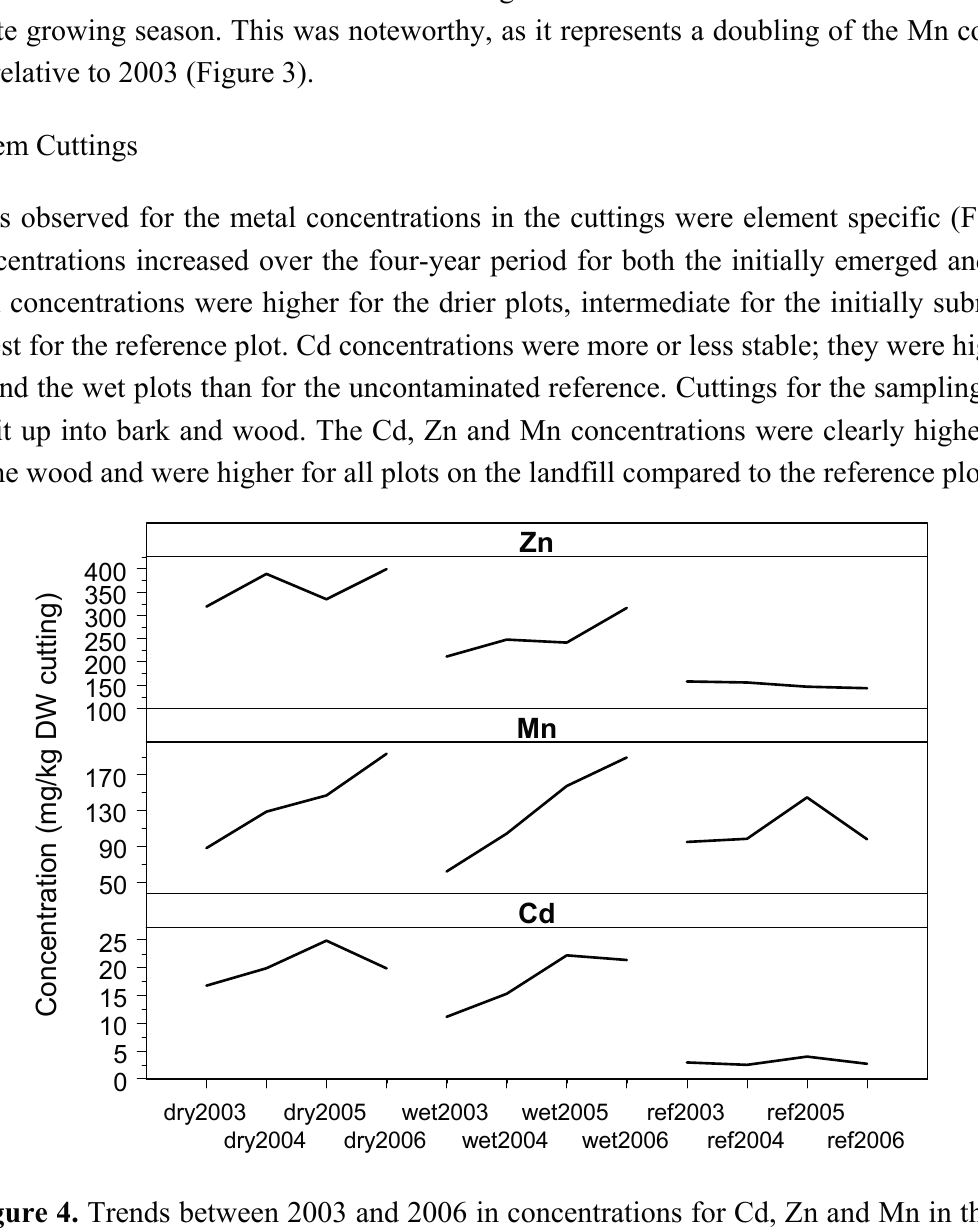
Figure 4. Trends between 2003 and 2006 in concentrations for Cd, Zn and Mn in the stem cuttings at the end of the growing season for the reference plot (ref, Plot 0), the plots already emerged in 2003 (“dry”, Plots 1 + 2 +3 ) and the plots submerged in 2003 (“wet”, Plots 4 + 5 + 6) (DW: dry